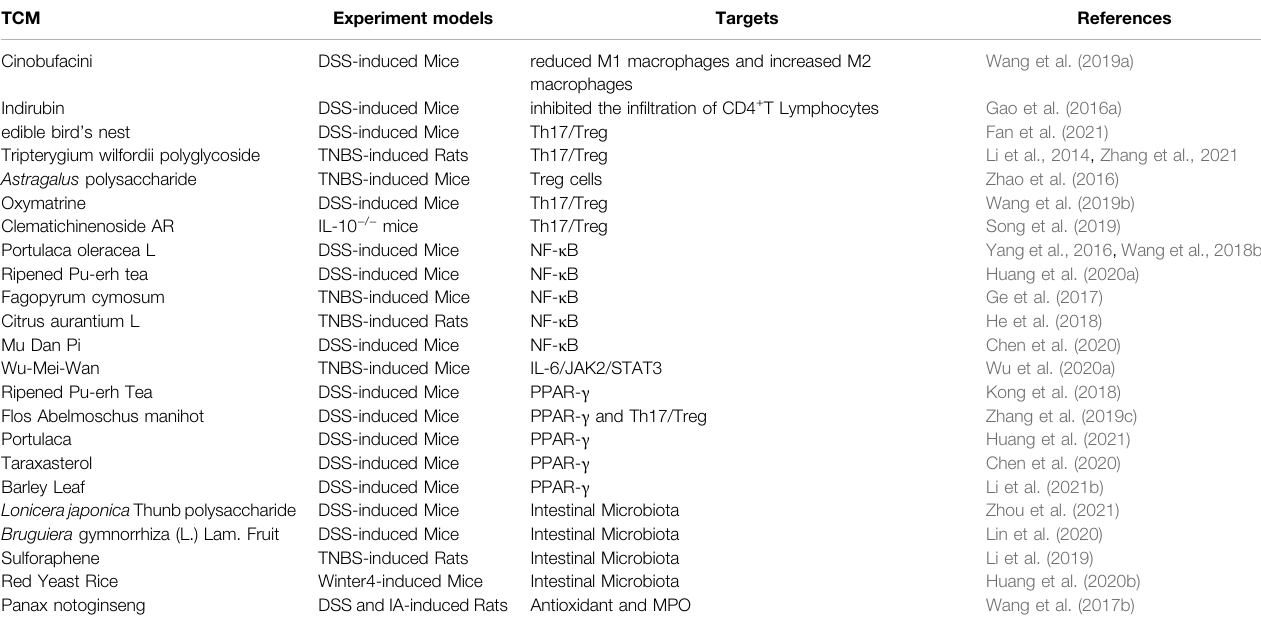
TABLE 1 | The targets of TCM in attenuating